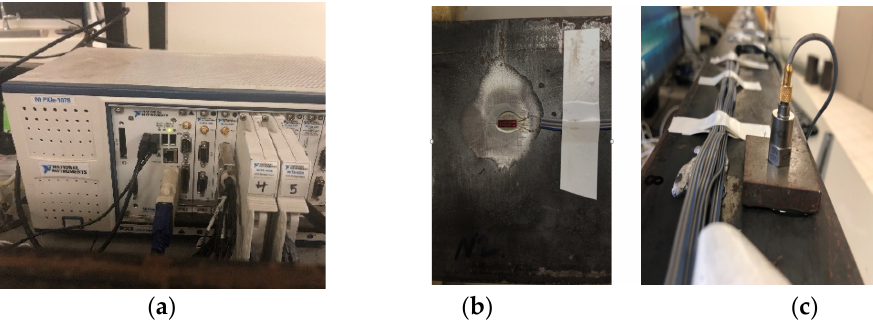
Figure 13. ( a ) Data acquisition system, ( b ) strain gauge and ( c ) accelerometer.